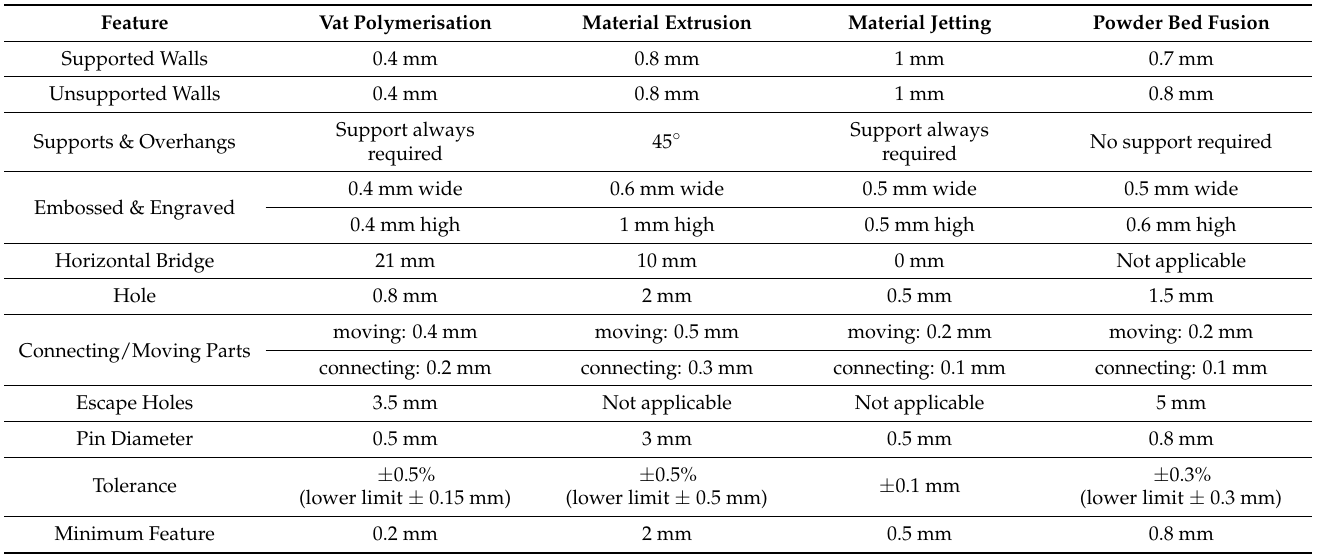
Table 2. Recommended feature-specific values for several polymer-based 3D printing